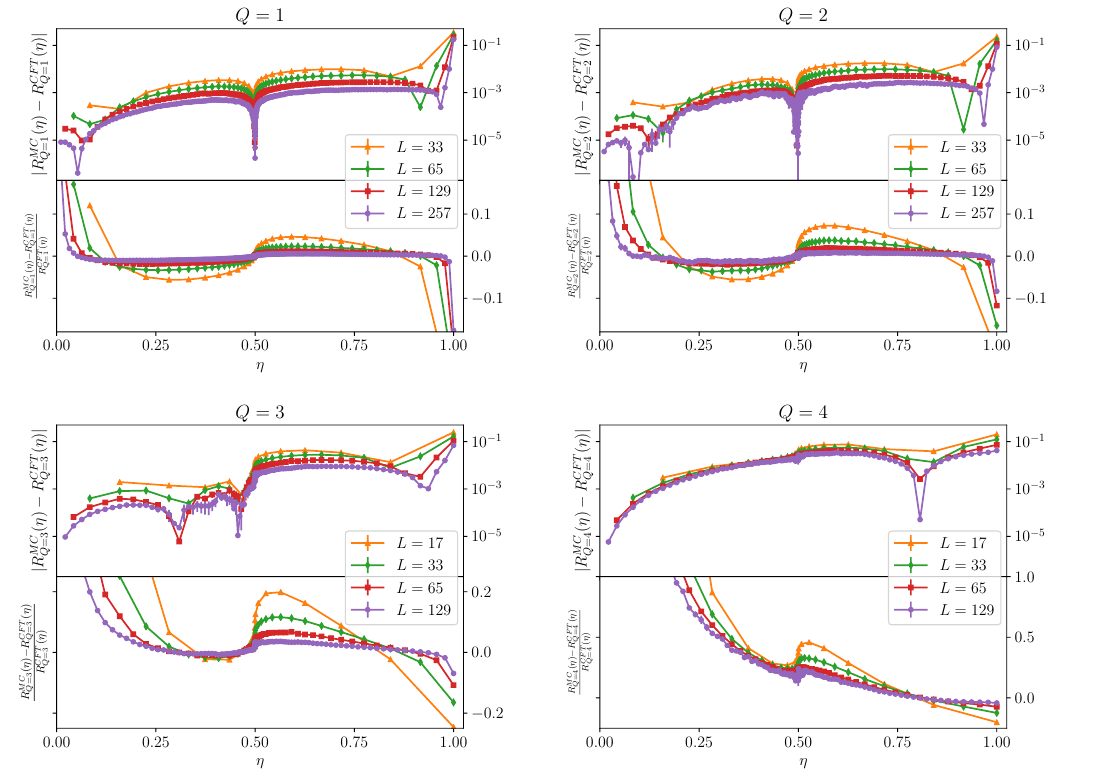
Figure 6 . The upper part of each plot shows the absolute value of the deviations from the CFT predictions discussed in section 4 (notice the logarithmic scale) while the lower part displays the signed relative